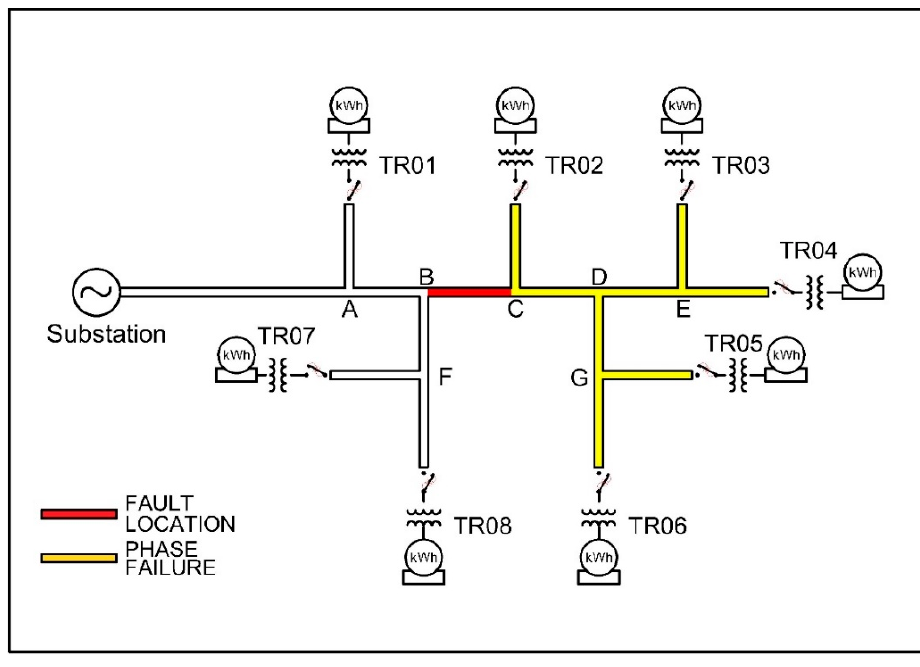
Figure 9. Faults on section BC.